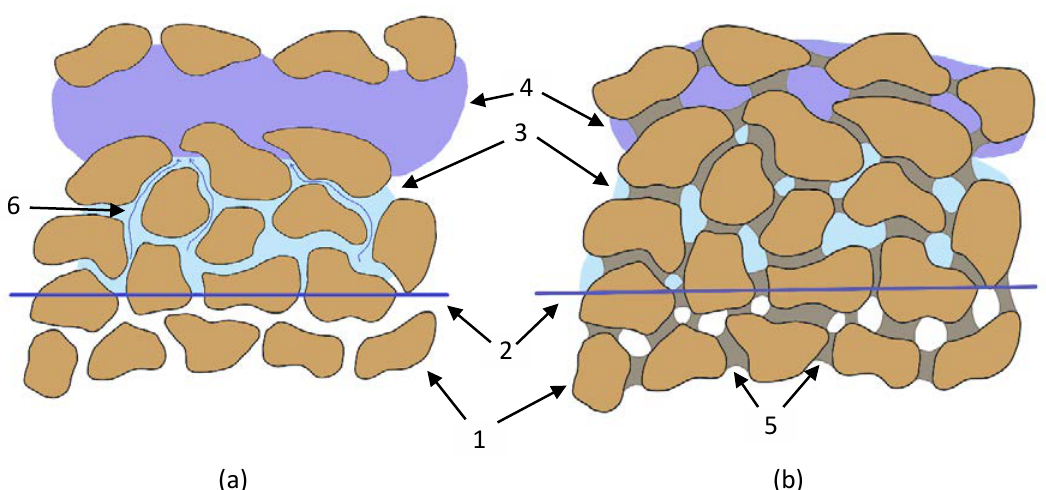
Fig. 7: Frost heave of untreated (a), and treated (b) soils: soil particles (1), freezing front (2), void ice (3), ice lens (4), precipitated calcite (5), and the path of water through ice lens (6)